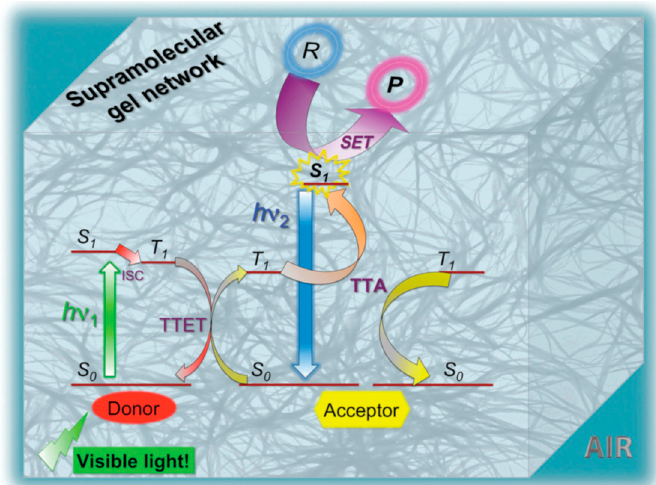
Figure 4. Schematic representation of chemical reactions powered by upconverted singlet energy. This event can be achieved using visible light at room temperature and in air when confined into a gel doped with a donor/acceptor pair. R = reactant; P = product. Adopted with permission from [30]. Copyright 2015 Royal Society of Chemistry.